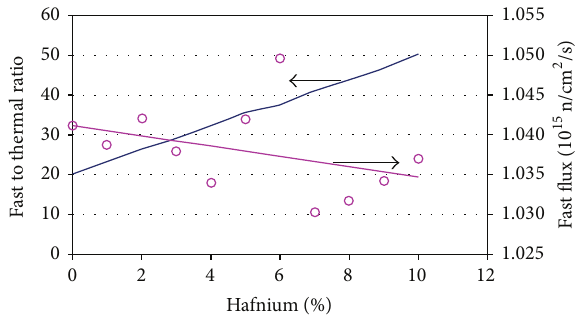
Figure 17: Sensitivity of fast-to-thermal ratio (blue line) and fast flux intensity (magenta line) to the Hf content in the Al central filler piece (absorber). The cycles on the graph correspond to the fast flux measurements [13].